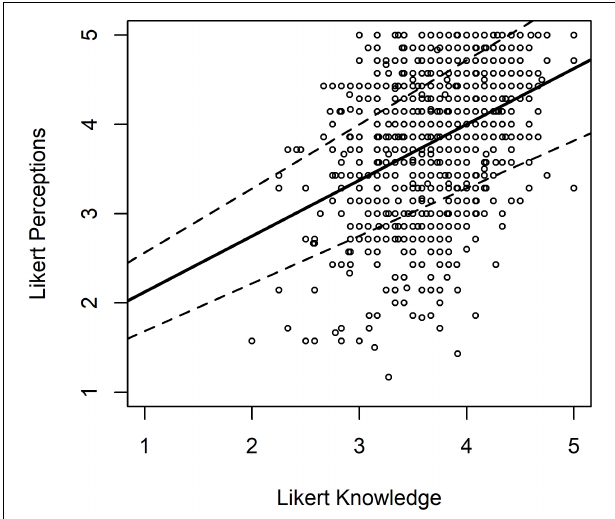
FIGURE 5 | Linear regression model of respondent’s knowledge about sharks against respondent’s perceptions toward sharks assessed with 5-level Likert data. The solid line represents the model estimate, the dashed lines represent 95% confidence intervals and blank circles represent the empirical data. Coefficients for intercept and slope were 1.498 and 0.626,